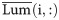
A: An edge image partitioned. For each pixel of the image localized at the row i and the column j we can compute a value of luminance, Lum(i,j). B: One-dimensional profile of the edge image obtained by computing the mean normalized luminance value of each patch row i, Lum¯(i,:).